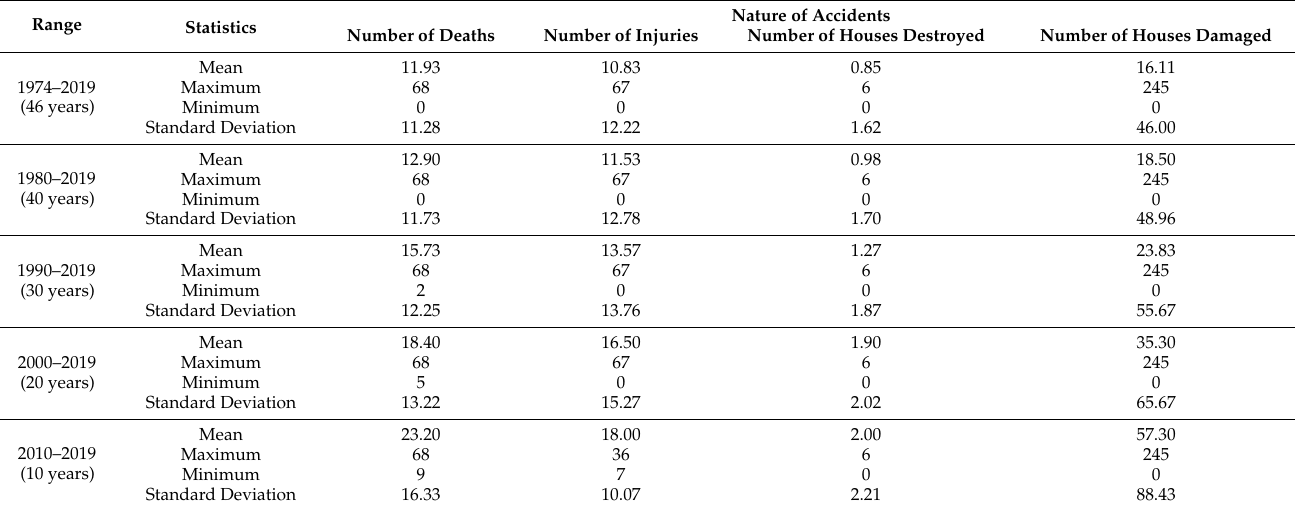
Table 6. Statistical overview of the lightning accidents reported in Sri Lanka, from 1974 to 2019. Range